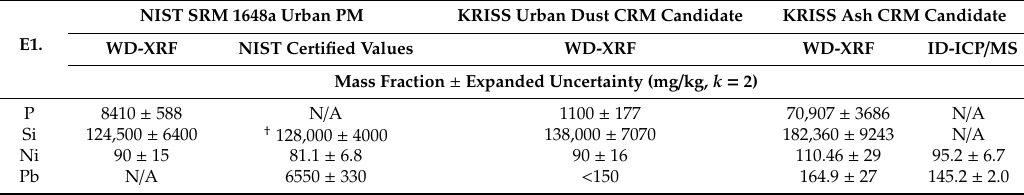
Table 3. Mass fractions of elements in NIST SRM 1648a urban PM, KRISS urban dust CRM candidate, and KRISS ash CRM candidate analyzed by WD ‐ XRF and ID ‐ ICP/MS.